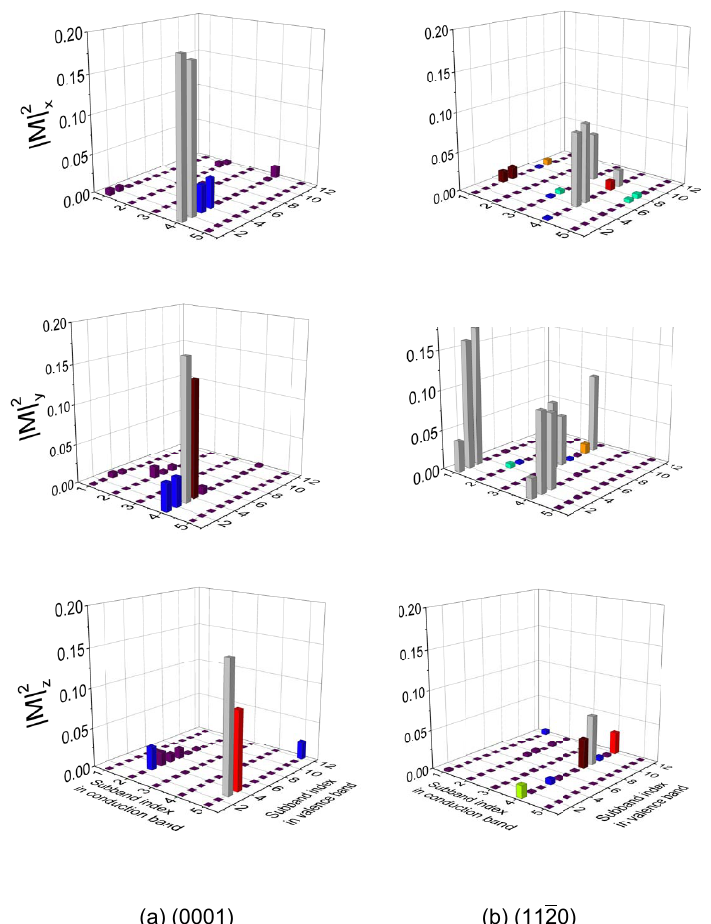
Figure 4. Normalized optical matrix element for x -, y -, and z -polarization for ( a ) (0001)- and ( b ) (11¯20)-oriented a-plane GaN/AlN QD structures grown on GaN substrate.